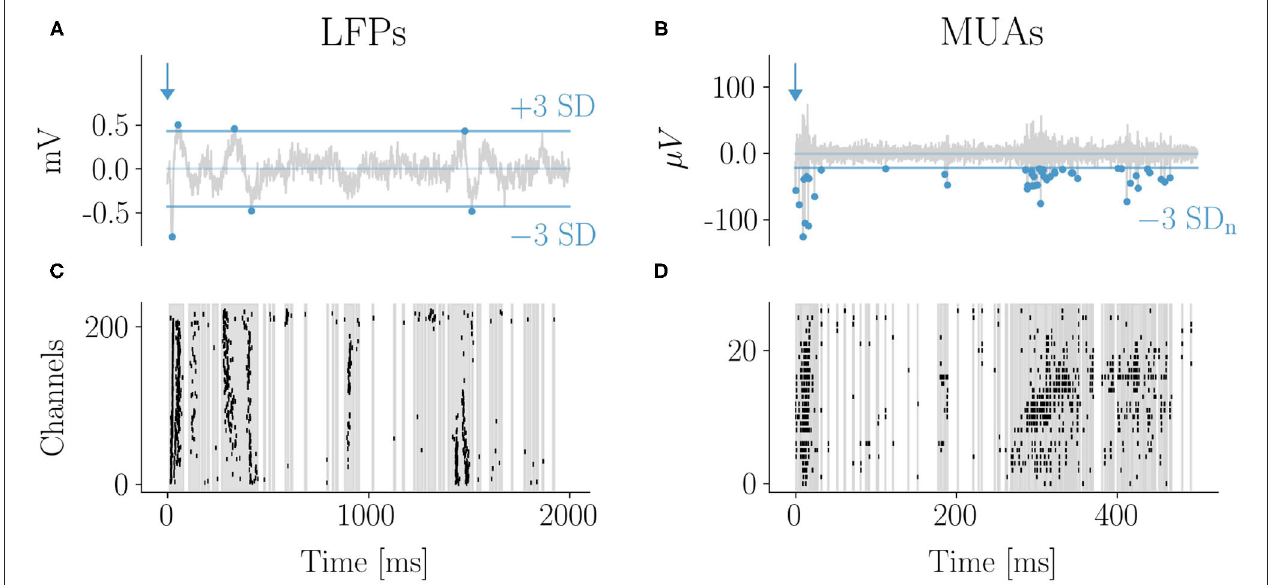
FIGURE 2 | Evoked response by whisker stimulation: LFPs and MUAs. Example of LFP (A) and spike (B) traces with the 3 standard deviations (SD) thresholds used for events detection (indicated by dots). The corresponding raster plots are shown in (C,D) . The 2D array in (C) was rearranged in one dimension (groups of four sensors in a row are reported consecutively along the vertical axis). The early response to the stimulus occurred within few tens of milliseconds and was characterized by a high degree of events synchronization across channels both for LFPs and MUAs. The typical LFP evoked response consisted in a first negative peak followed by a slower positive wave. Both were detected as events which is reflected in the raster plot. After the early response large and frequent avalanches typically followed, taking the form of oscillations of synchronous events across channels fading after a few hundreds of milliseconds from the stimulus. Correspondingly, epochs of high frequency firing (bursts) were observed in the MUAs domain (C,D)